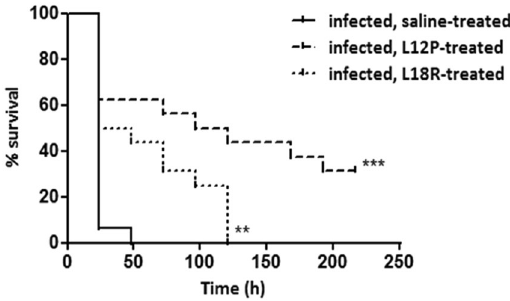
Figure 1. In vivo therapeutic activity of L12P and L18R peptides. Groups of 16 Galleria mellonella larvae were infected with 5 × 10 5 cells of Candida albicans SC5314 and administered 1 h later (single injection, 10 μ l) with peptides (12.5 mg/kg) or saline solution (control group). Larvae were then incubated at 37 °C in the dark for 9 days, and scored daily for survival.The survival curves of peptide-treated animals were significantly different from that of control group, as assessed by the log-rank (Mantel-Cox) test ( ** p = 0.0016, *** p = 0.0001). Data reported are from one representative experiment out of two experiments with comparable results.